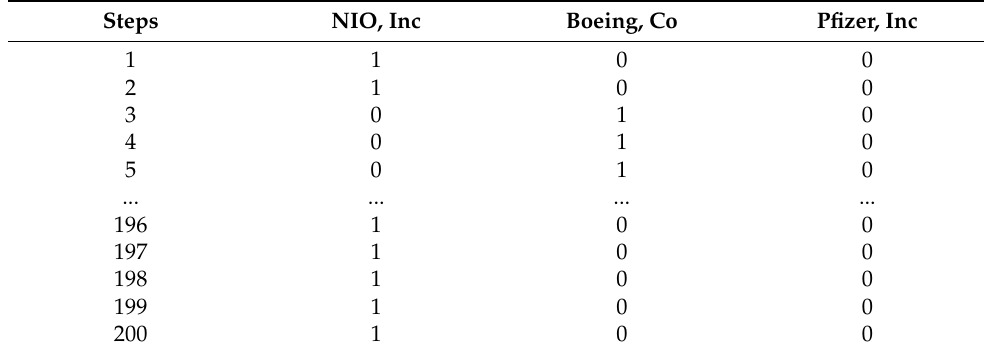
Table 2. Table 2. Portfolio structure of half-hourly